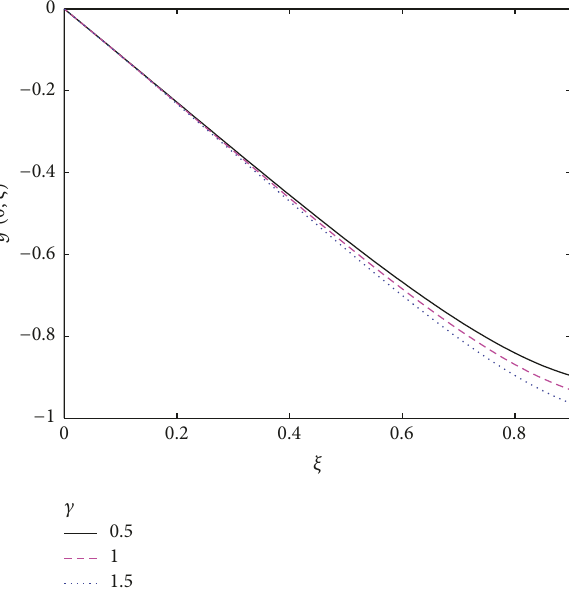
Figure 13: Effect of Sc on 𝑓 󸀠󸀠 (0,𝜉) ( 𝜎 = 𝛾 = 0.5, Pr = 3, 𝜆 = 1, ℏ = −0.5 ).